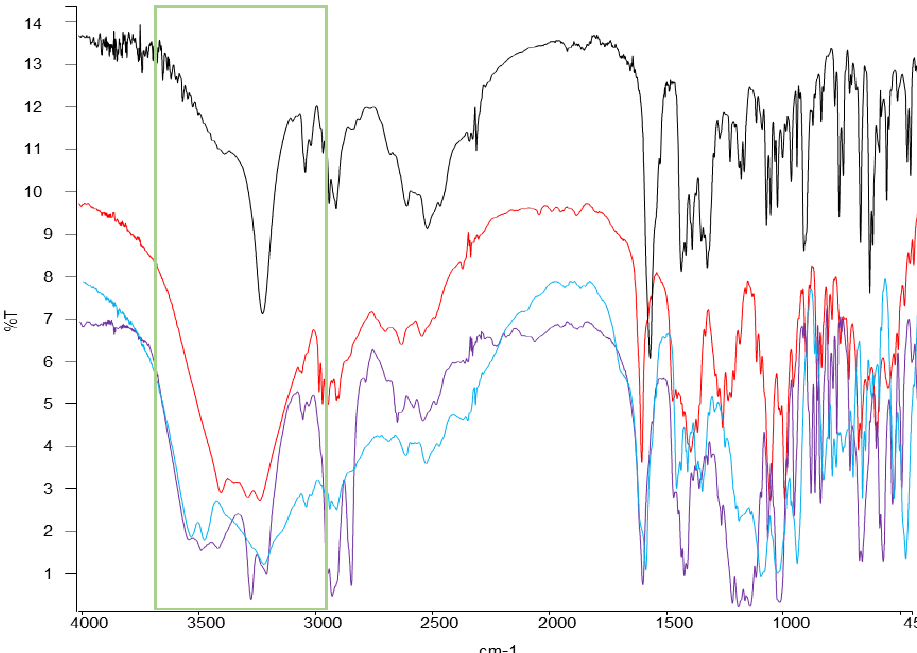
Figure 3. IR spectrum of the active pharmaceutical ingredient (API) loperamide HCl and excipients mannitol (red), sodium cyclamate (purple) andEmcompress ® (blue).